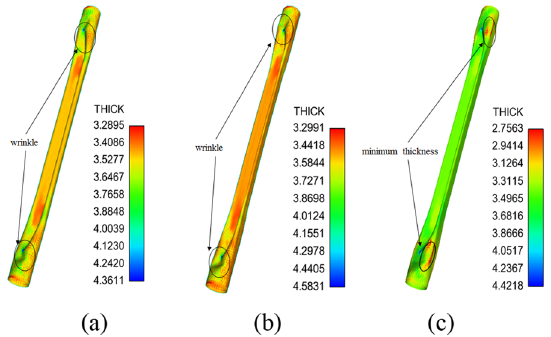
Figure 28 Cloud maps of thickness distribution at different stages: ( a ) Closing of upper mold clamping, ( b ) Closing of sliding mold clamping, ( c ) Closing of hydraulic bulging